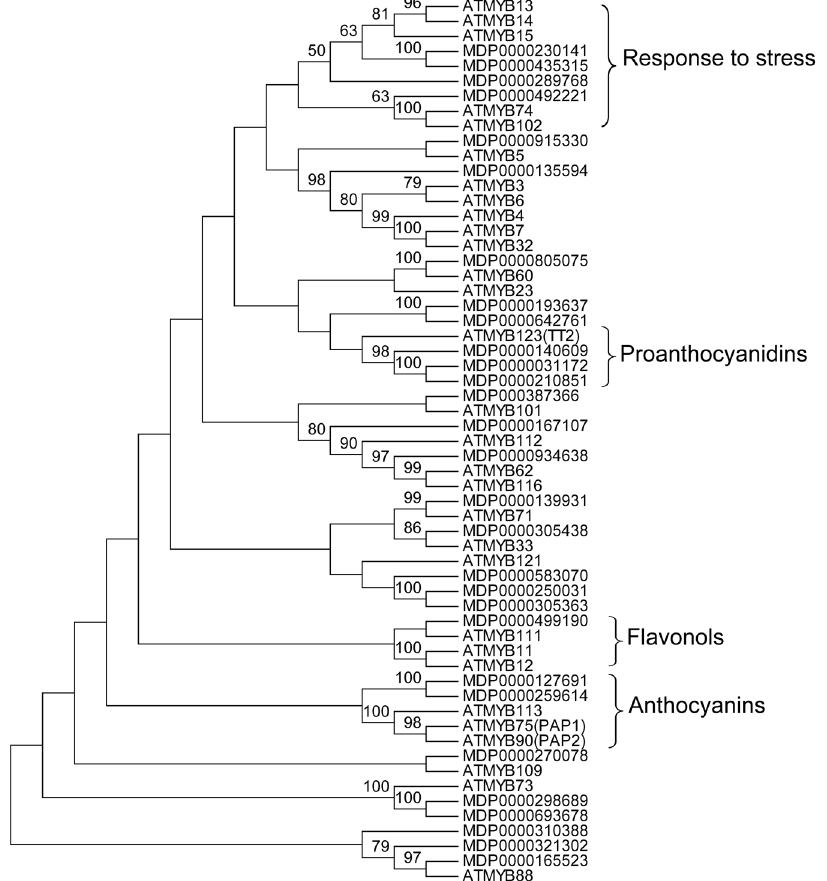
Fig 5. Phylogenetic analysis of MYB transcription factors in apple and their homologues in Arabidopsis